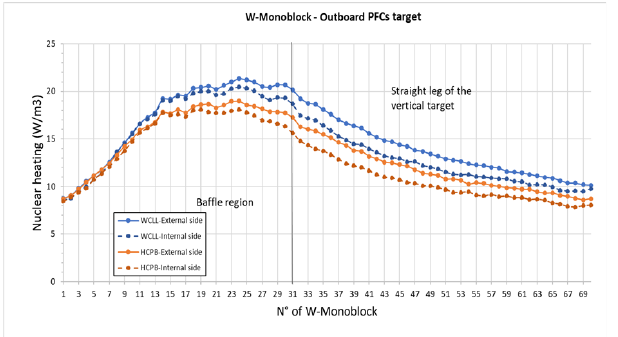
Figure 33. Outer poloidal profiles of the nuclear heating (W/cm 3 ) on W-Monoblocks, comparing the values on the external and innermost target sides, both for WCLL and HCPB blanket